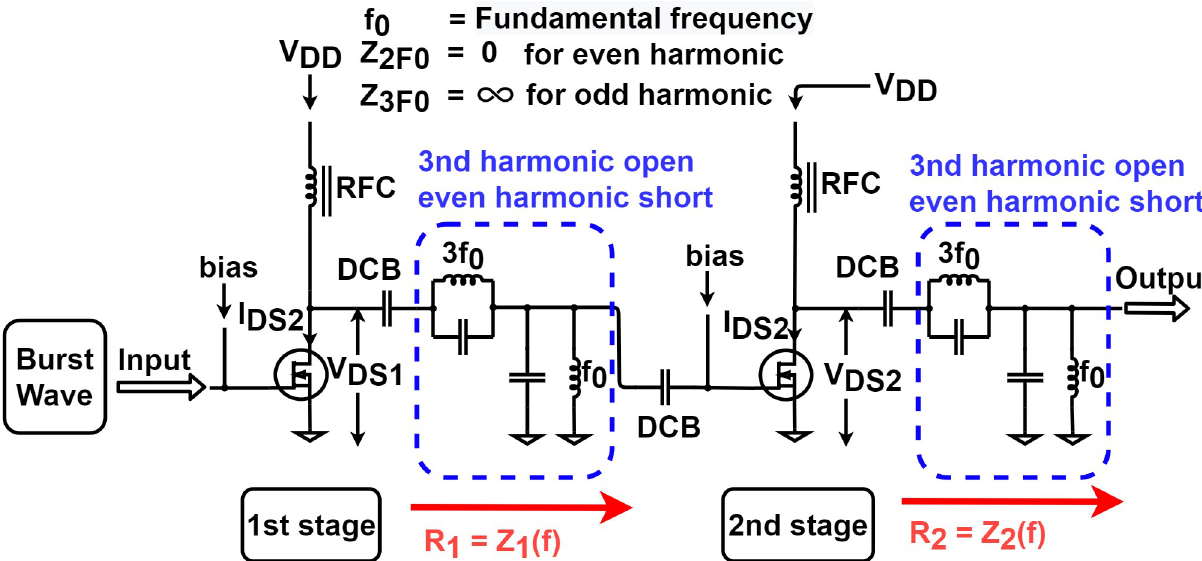
Fig 4. The ideal schematic diagram that is to calculate the drain efficiency of the two-stage class F amplifier which controlled only third harmonic.